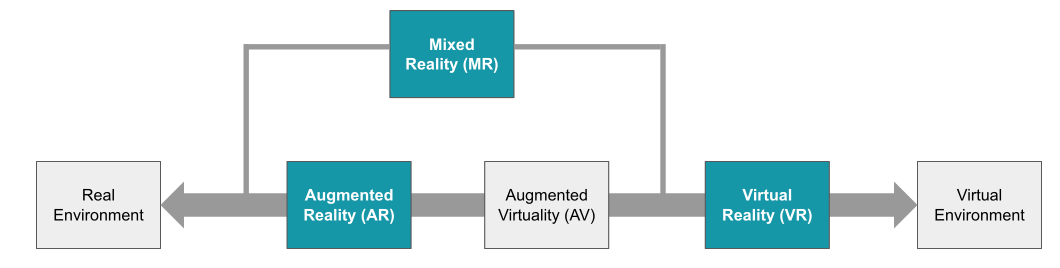
Figure 1. Reality–Virtuality continuum adopted from